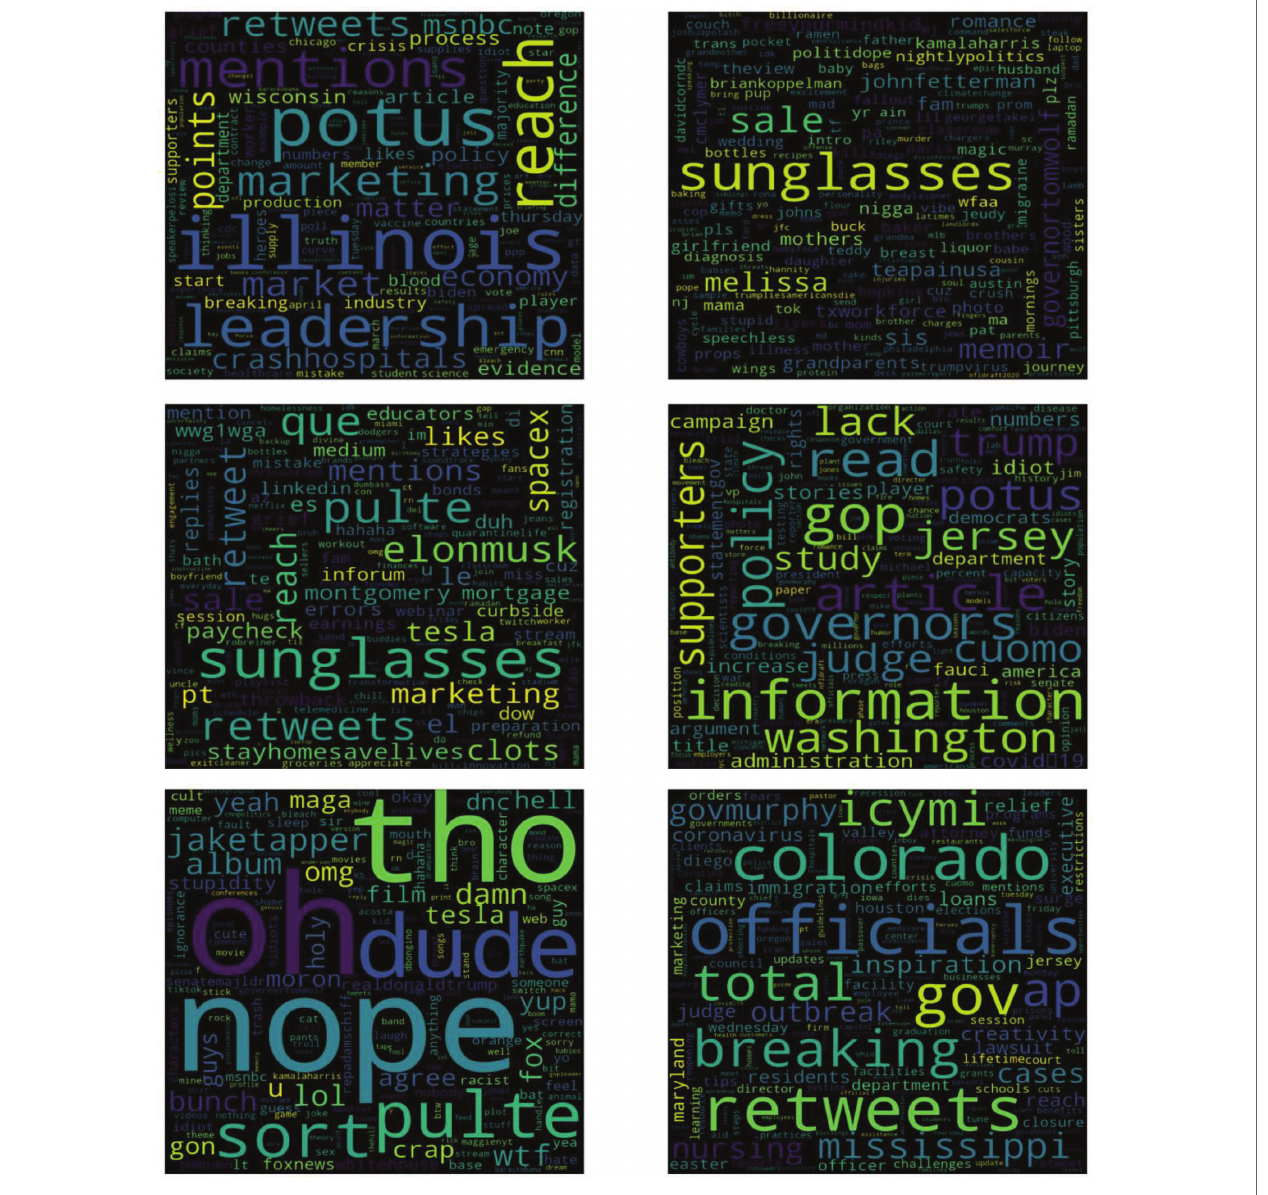
FIGURE 5 | Differences in language usage between groups low in family connectedness and high in family connectedness (top), groups low in openness and high in openness (middle), and groups low in conscientiousness and high in conscientiousness (bottom). Note: The word cloud on the left shows words that are more frequently used by users low in family connectedness/openness/conscientiousness. Larger words represent a sharper contrast with users high in the construct. The word cloud on the right displays words more frequently used by those high in the construct. Larger words represent a sharper contrast with users low in family connectedness (e.g., words in the top right figure are used more frequently by people high than low in family connectedness; sunglasses are talked about 10 times more). For family connectedness, we used tweets from 1,325 users with a family connectedness score equal to 0 and 205 users whose family connectedness score was higher than 1 as per our corpus. For openness, we used tweets from 294 users with an openness score smaller than 0.6 and 775 users whose openness score is higher than 0.9 as per our corpus. For conscientiousness, we used tweets from 608 users with a conscientiousness score smaller than 0.2 and 412 users whose conscientiousness score is higher than 0.75 as per our